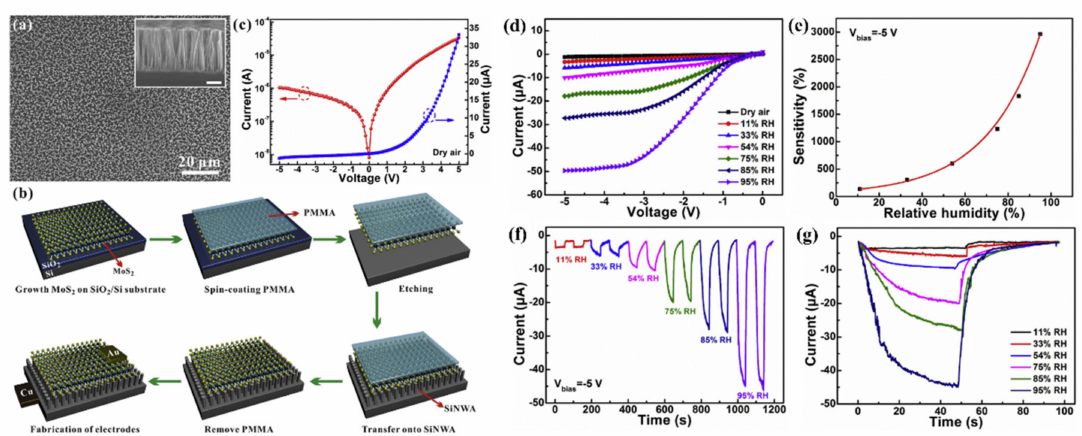
Figure 22. ( a ) SEM top and cross-section images of the SiNWs (The inset’s scale-bar is 2 µ m). ( b ) the schematic diagram of process flow for a MoS 2 / SiNW heterojunction device, ( c ) I-V curves of MoS 2 / SiNW heterojunction in dry air, ( d ) I-V curves of MoS 2 / SiNW heterojunction at reverse voltage under varied RH values, ( e ) the dependence relation between sensitivity and relative humidity. ( f ) current response of MoS 2 / SiNW heterojunction to dynamic switches between dry air and varied RH valu,s at V bias = − 5 V, and ( g ) single-cycle response with di ff erent RH values. Reproduced from [162], with permission from Elsevier,